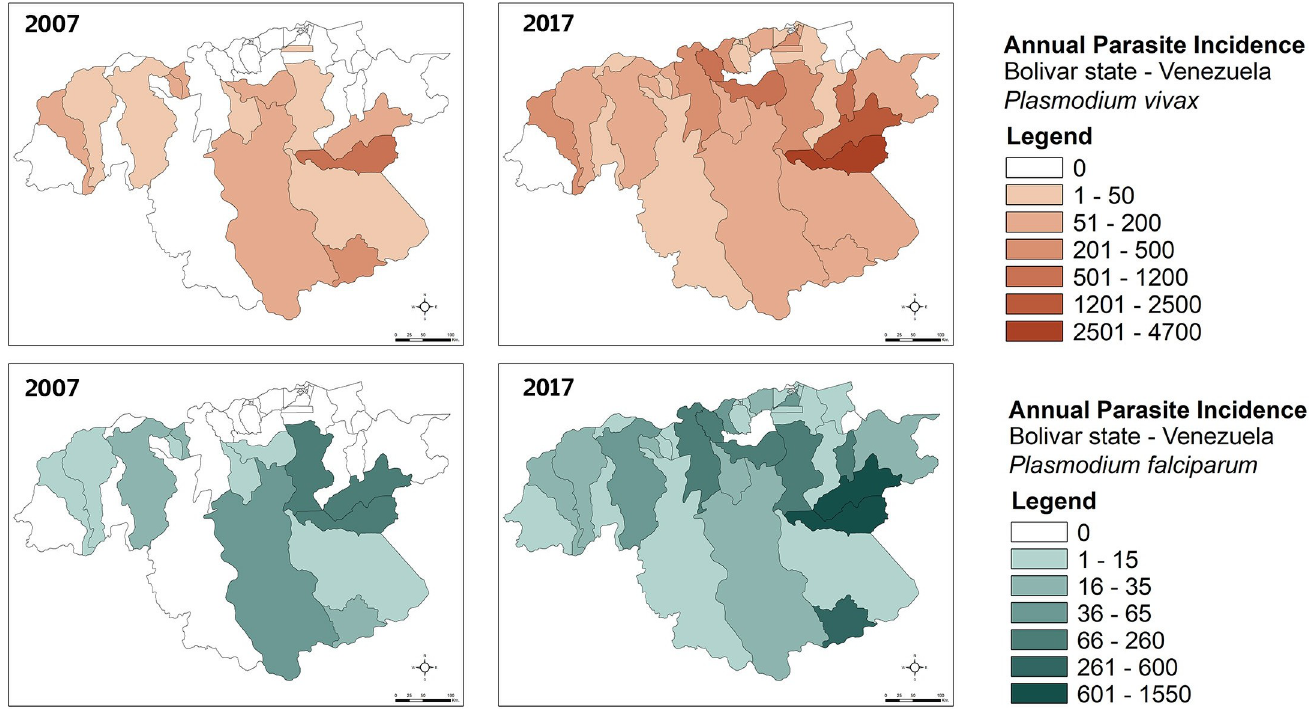
Fig 3. Annual P . vivax (A, B) and P . falciparum (C, D) incidence (API: Number of confirmed malaria cases/1,000 inhabitants) per parish in Bolı´var state (2007 and 2017), south-eastern Venezuela. Maps were created with the Q-GIS software (https://www.qgis.org/es/site/).